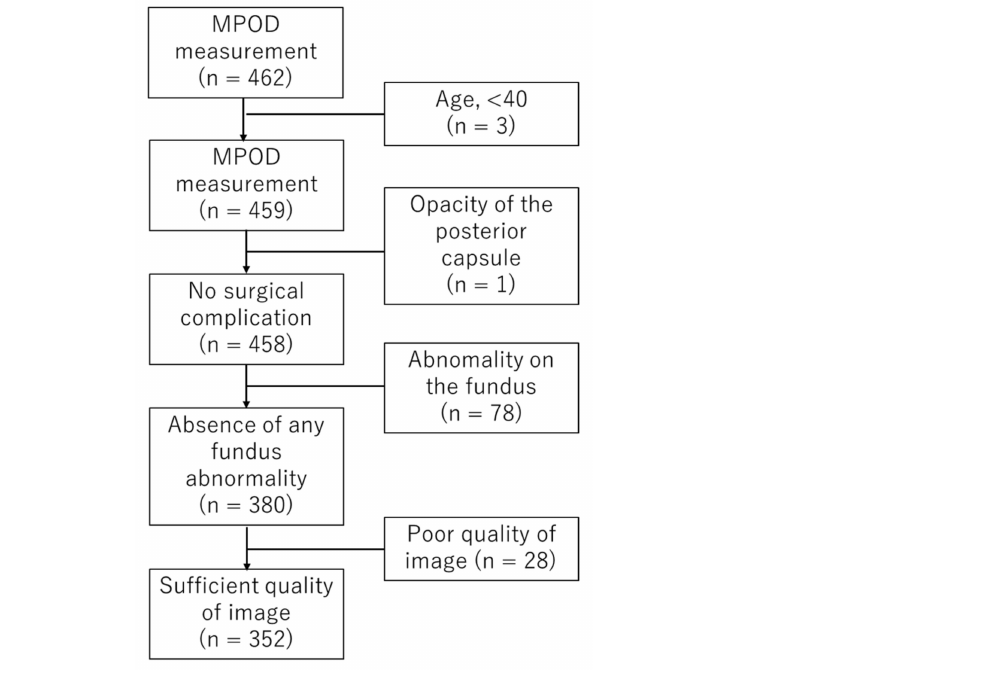
Figure 1. Flow diagram of subject selection. In total, 355 eyes were selected from 462 eyes. N indicates the number of